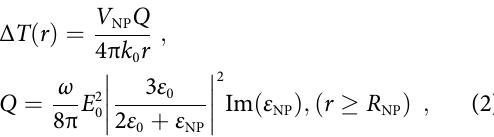
Fig. 4 | ( a ) Measured resistance of the Ag NWs electrodes as a function of the laser nanosoldering power density with the laser nanosoldering time of 11 min. ( b ) Measured resistance of the Ag NWs electrodes as a function of the laser nanosoldering time with laser nanosoldering power density of 7.01 MW/cm 2